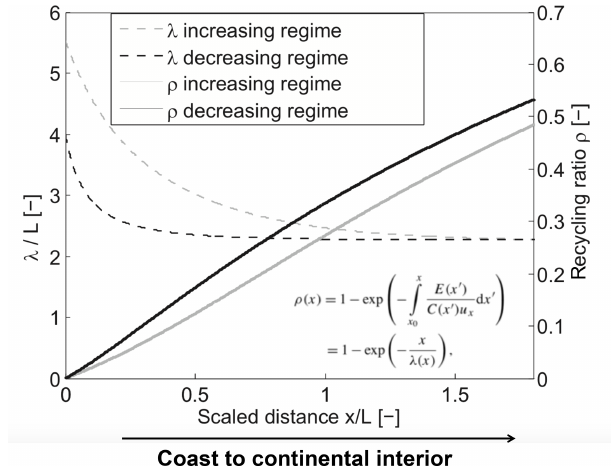
Figure 16. Continental recycling ratio, ρ , and recycling length scale, λ , normalized by length scale, L , along the inflow direction x for atmospheric moisture, either increasing or decreasing along the inflow path in the idealized model of Schaefli et al. (2012). ρ represents how much of the rainfall is derived from terrestrial evap- otranspiration, while λ represents the length scale over which evap- otranspired water is